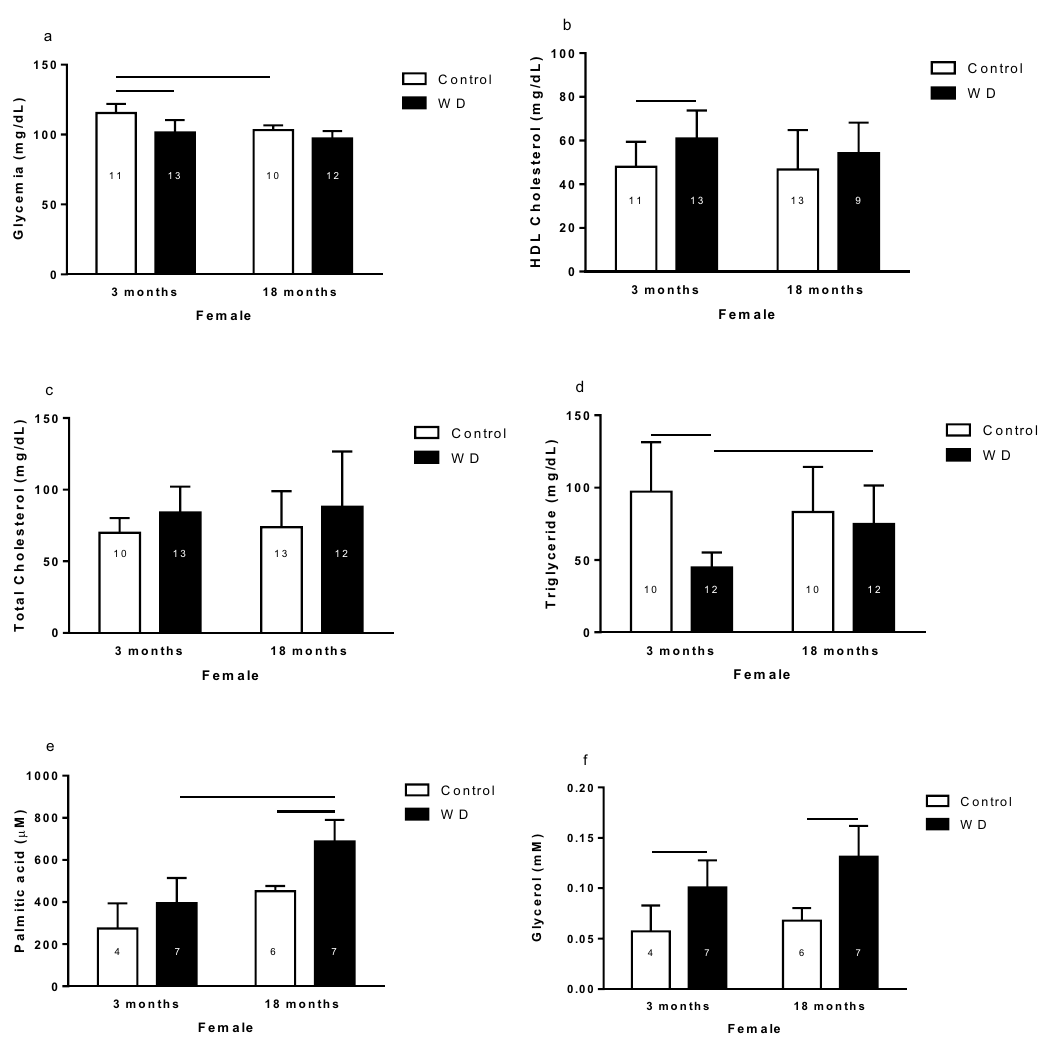
Figure 4. Glycemia ( a ), HDL cholesterol ( b ), total cholesterol ( c ), triglyceride ( d ), palmitic acid ( e ), and glycerol ( f ) of 3- and 18-month-old female control and rats with water deprivation (WD). Data are presented as means (SD), p < 0.05 among the indicated groups. Two-way ANOVA followed by Newman-Keuls or Duncan post-test when variances were equal, and Games-Howell when variances were different. The n for each group is inside the